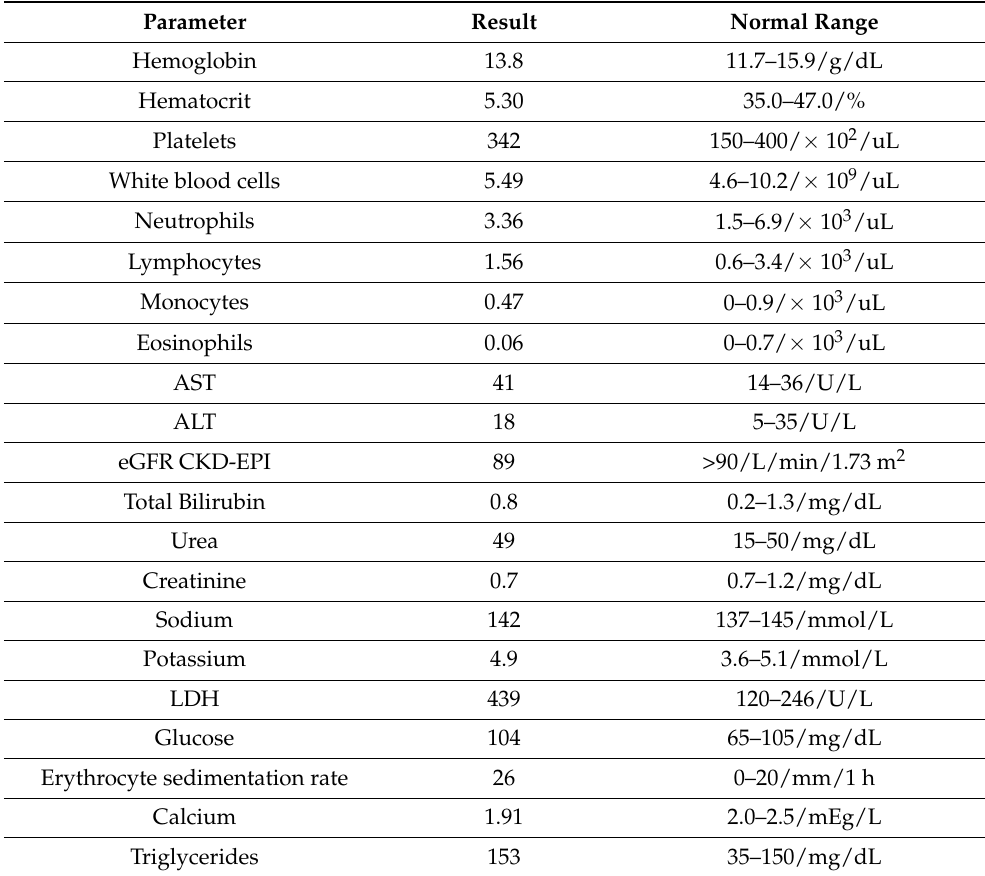
Table 1. Blood tests before targeted therapy